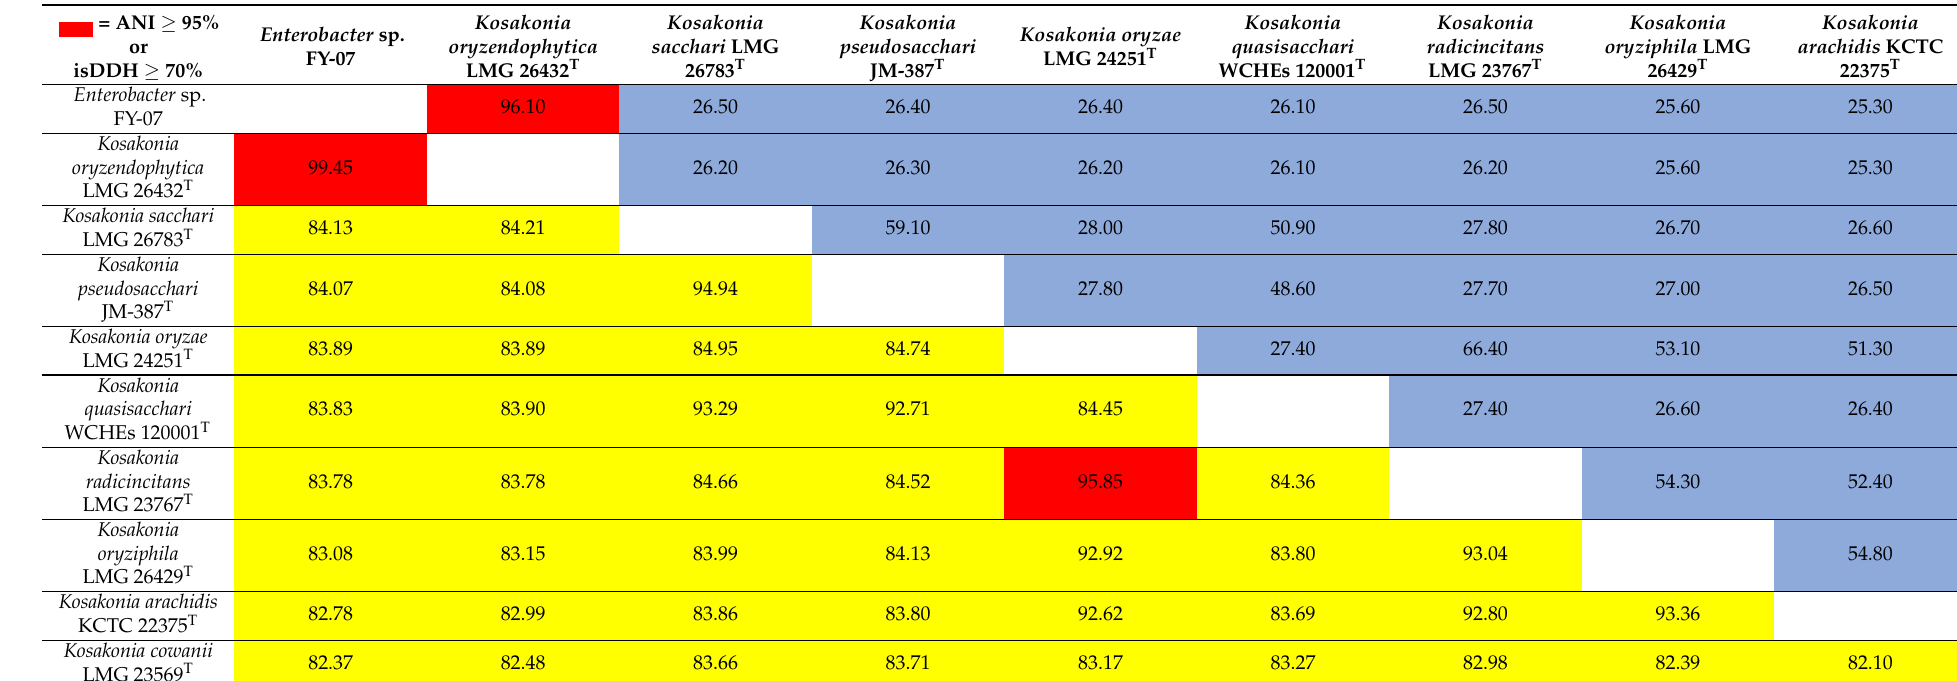
Table 1. Pairwise comparisons of isDDH and ANI values of FY-07 and type strains of the genus